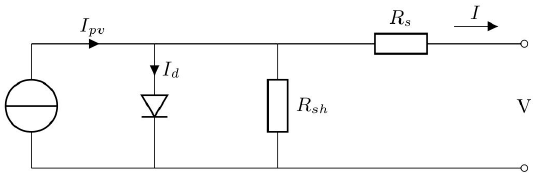
Figure 28. Diode model used to describe the behaviour of the PV cell.